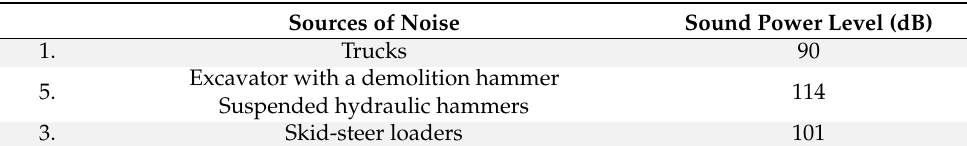
Table 3. Expected sources of construction noise.